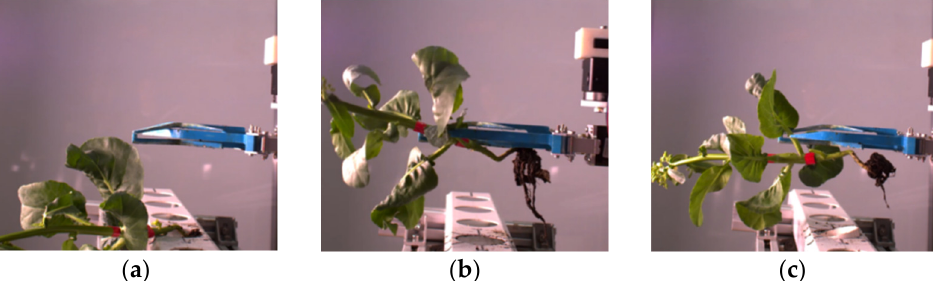
Figure 15. Failed attempts at grabbing kale in the test: ( a ) the hydroponic Chinese kale was not grasped, ( b ) the stalk of the kale was stuck in the finger, and ( c ) only the leaves of the hydroponic Chinese kale were grasped.